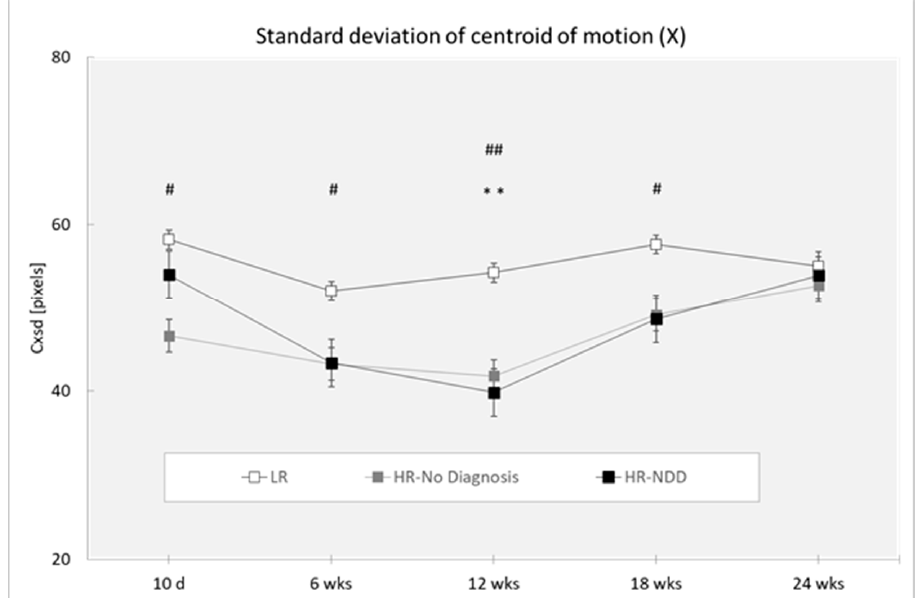
Figure 3. Standard deviation of centroid of motion in X direction (Cxsd) in a 3-min session, measured at 10 days and 6, 12, 18, and 24 weeks in three groups of infants (LR, n = 53; HR-no diagnosis, n = 32; HR-NDD infants, n = 18), d = days; wks = weeks. Data are expressed as mean ± SEM. ** p < 0.01 between HR-NDD and LR infants; # p < 0.05 and ## p < 0.01 between HR-no diagnosis and LR infants.